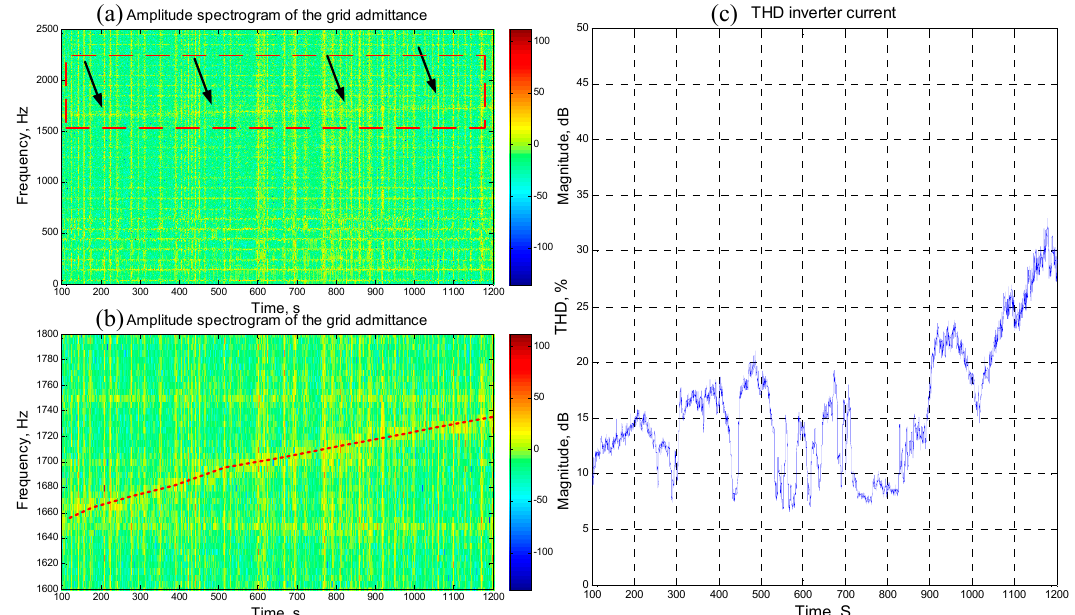
Figure 3. The measurement data for the Photovoltaic Charging Station: ( a ) grid admittance amplitude spectrogram; ( b ) partial enlargement of ( a ); ( c ) THD (total harmonic distortion) of inverter output current.